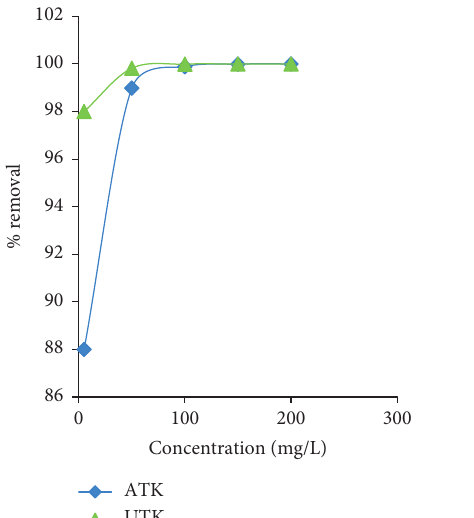
Figure 5: % removal of Cr (VI) ions versus concentration.